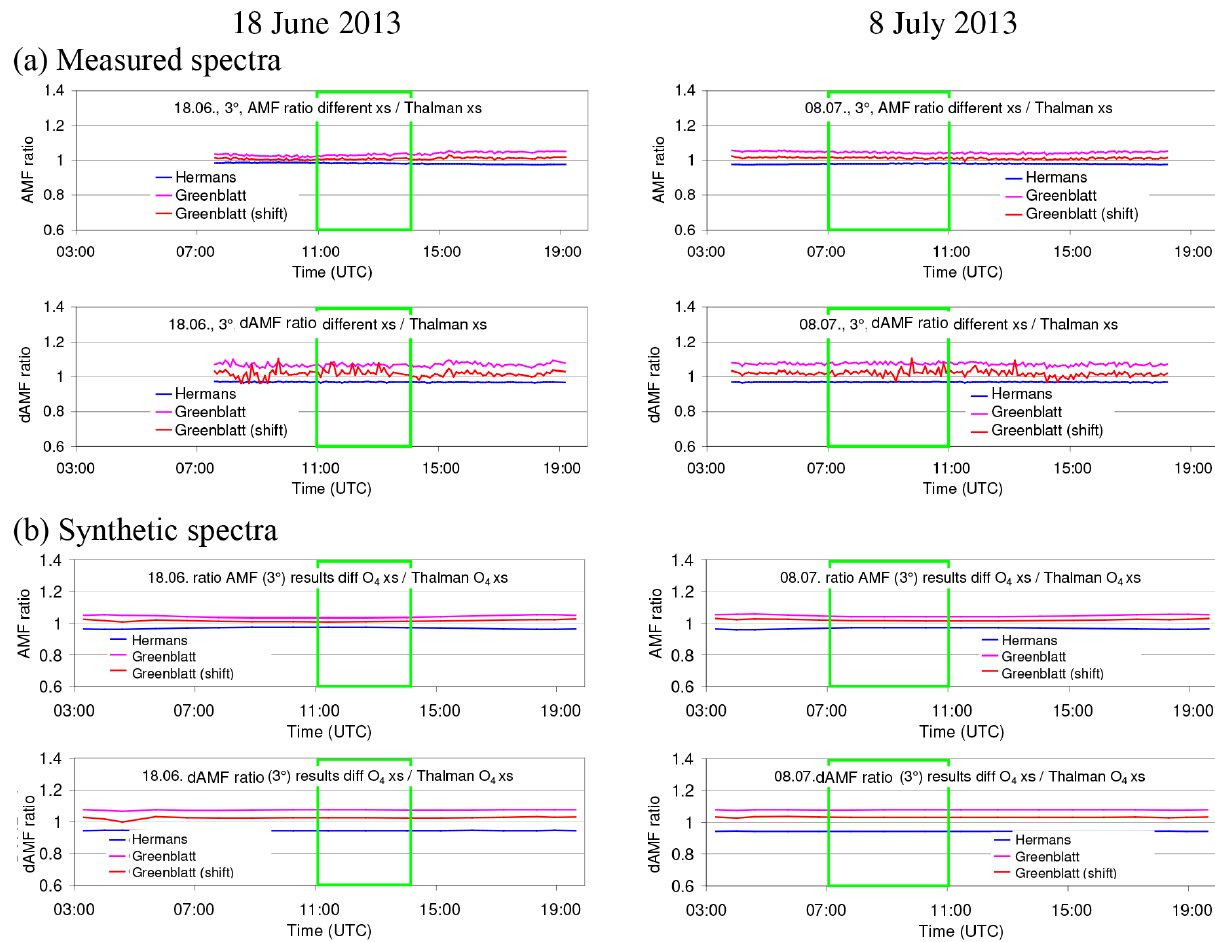
Figure A24. Ratios of the O 4 (d)AMFs derived for the analyses using different O 4 cross sections vs. those for the standard analysis (using the Thalman and Volkamer cross section) for both selected days ( a : results for spectra measured by the MPIC instrument; b : results for synthetic spectra when taking into account the temperature dependence of the O 4 cross